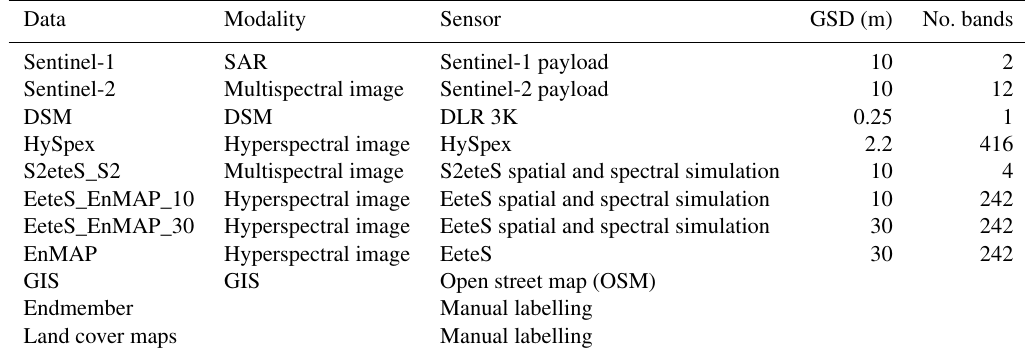
Table 2. This table lists data components of MDAS.